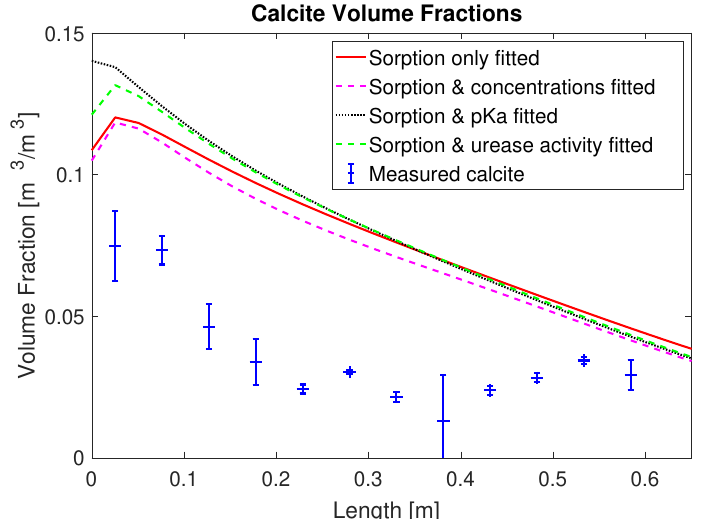
Figure 5. Predicted volume fractions of final calcite compared to the experimental data of column experiment #2 (0.66 M mineralization medium concentration): Note that, during this experiment, urease was only injected before every odd-numbered mineralization-medium injection. The error bars represent the standard deviation calculated from triplicate measurements. None of this experiment’s data were used for calibration.